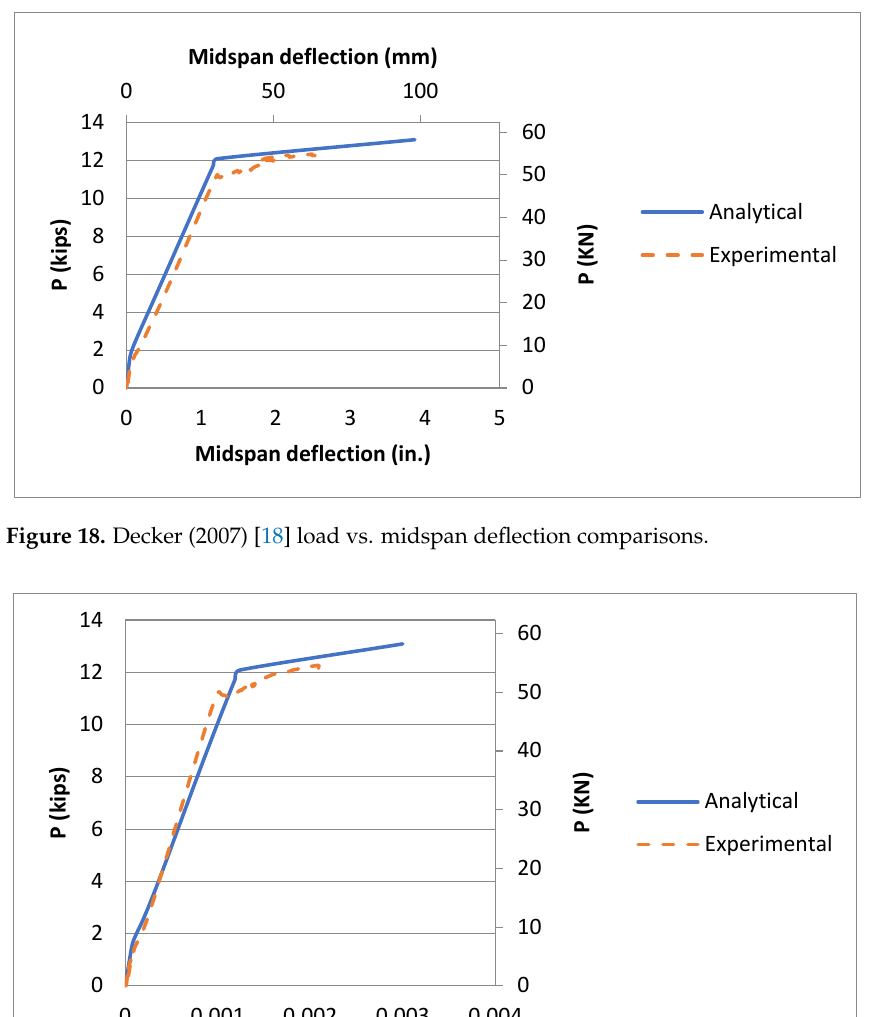
Figure 19. Decker (2007) [18] load vs. maximum compressive strain comparison.